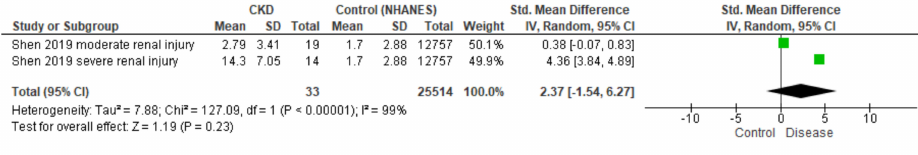
Figure 2. Mean difference analysis using the RevMan program calculates a value to use in the inverse variance analysis [30].